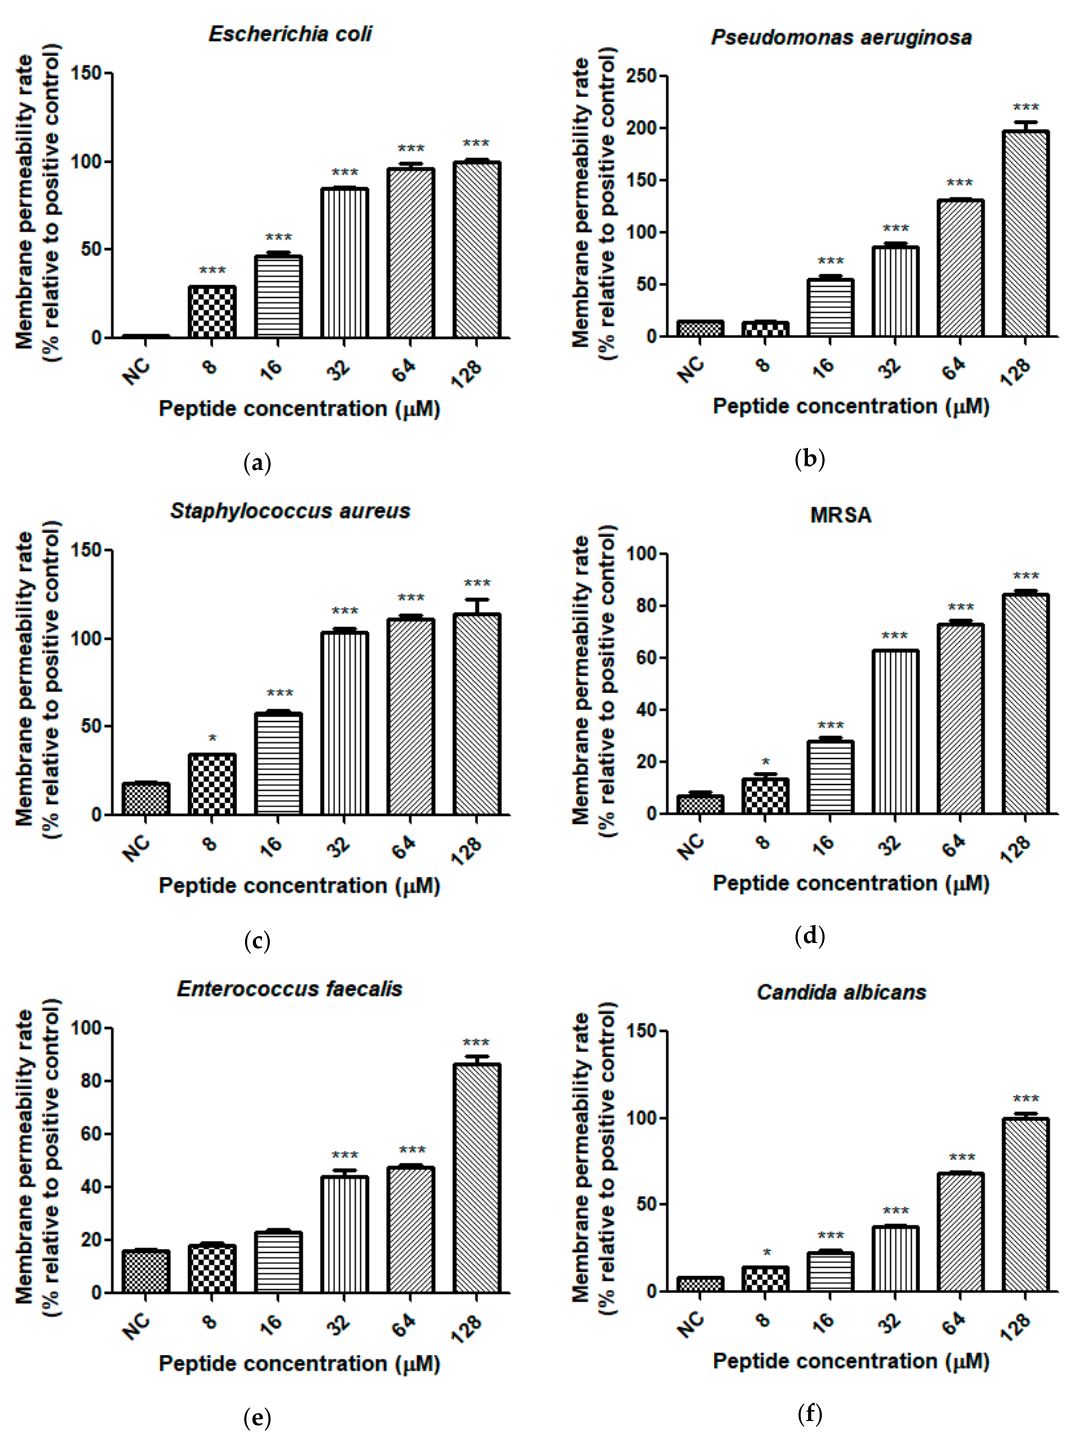
Figure 10. Cell membrane permeability effects of Dermaseptin-PH on ( a ) E. coli ; ( b ) P. aeruginosa ; ( c ) S. aureus ; ( d ) MRSA; ( e ) E. faecalis ; and ( f ) C. albicans , by using SYTOX Green (Life technologies, Carlsbad, CA, USA) assay at peptide concentrations corresponding to MIC results. Positive control was obtained following incubation with 70% isopropyl alcohol. Negative control (NC) was obtained following incubation with 5% tryptic soy broth (TSB) in 0.85% NaCl solution. Data represent means ± SEM of 5 replicates. The levels of significance are: * p < 0.05, *** p < 0.001.